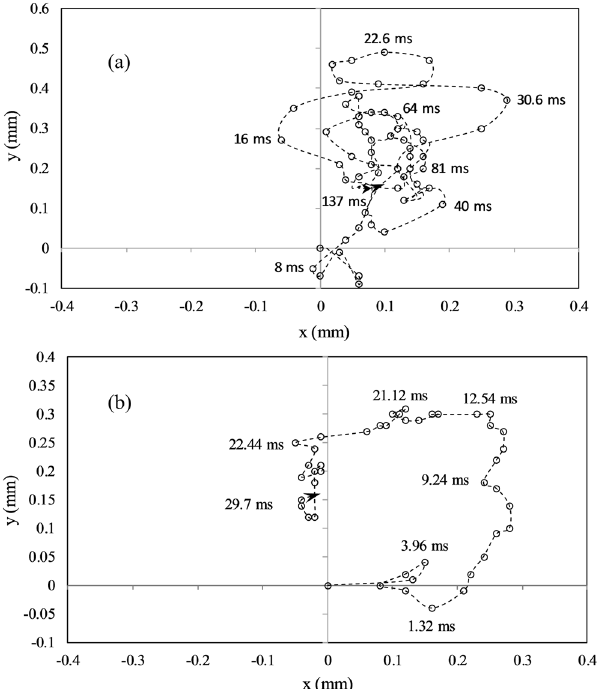
Figure 9. The trajectory of the droplet centroid following the onset of major bubble breakup at ( a ) center of the parent droplet ( α = 0.6) and ( b ) edge of the droplet ( α = 0.75), indicating severe oscillations of the droplet.